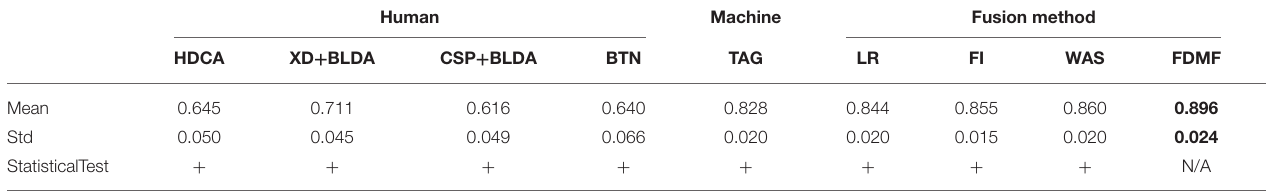
FIGURE 4 | The Rapid Serial Visual Presentation (RSVP) task.